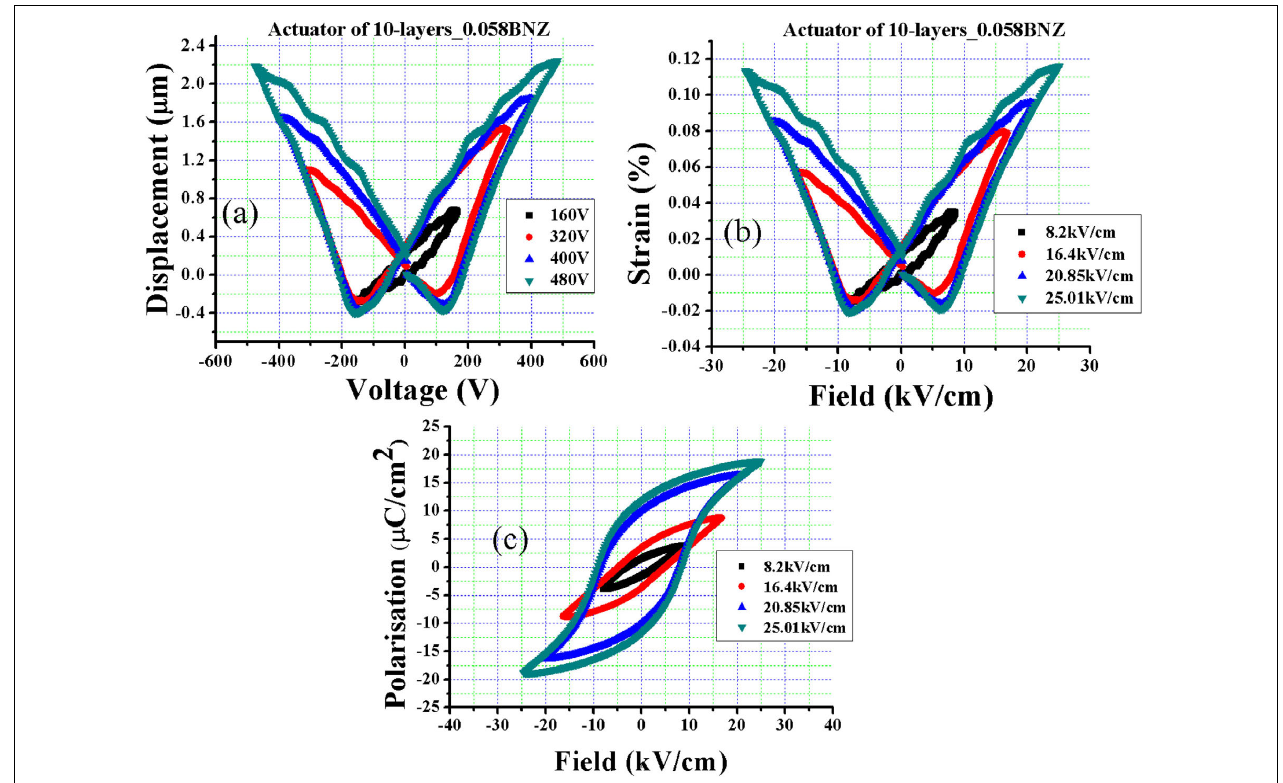
FIGURE 8 | 10-layers MLA sample of (0.942KNN-0.058BNZ) composition showing (a) displacement data, (b) strain data, and (c) ferroelectric